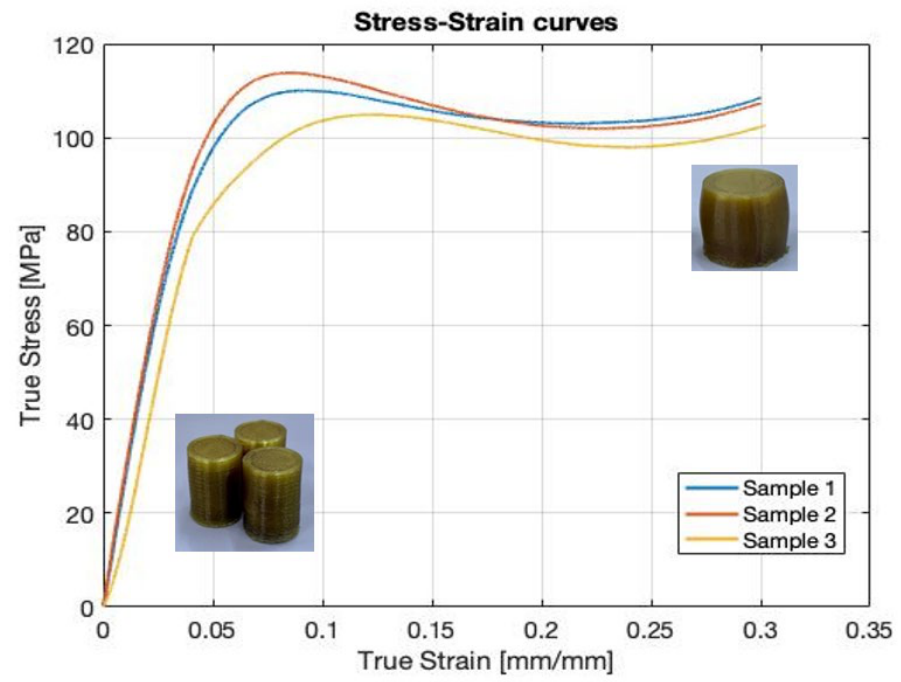
Figure 7. Compression stress-strain curves. Table 11. Mechanical compression test properties.